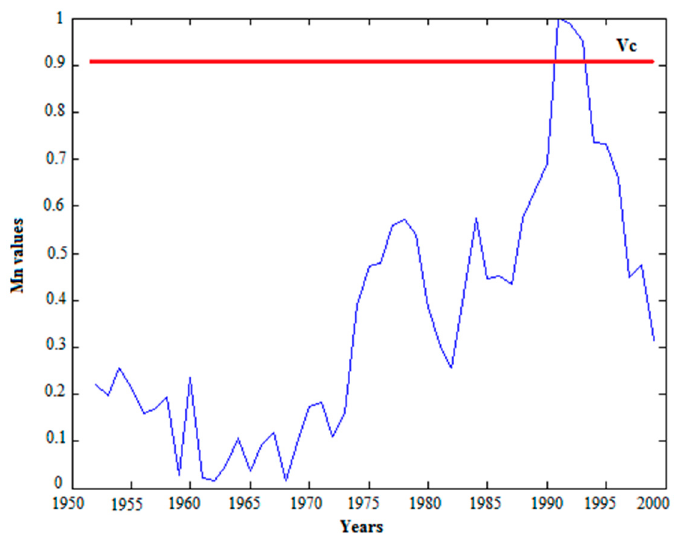
Figure 3. Temporal variability of M n values derived for the link between AO and TRN at the St-Malo d’Auckland station (1950–2000).